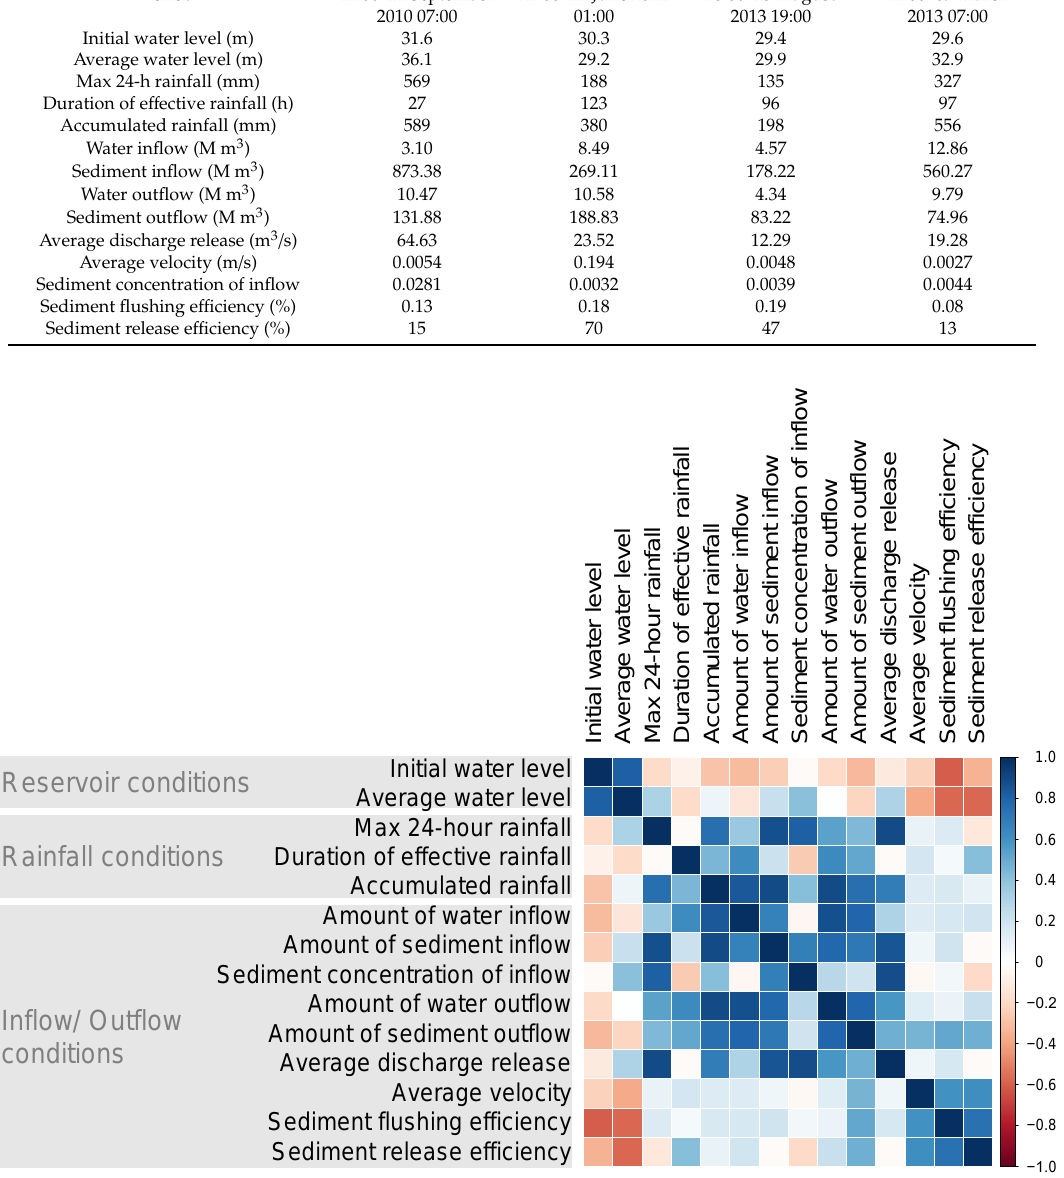
Figure 6. Coefficients of determination, r 2 , for variables describing the reservoir, rainfall, and inflow/outflow conditions.